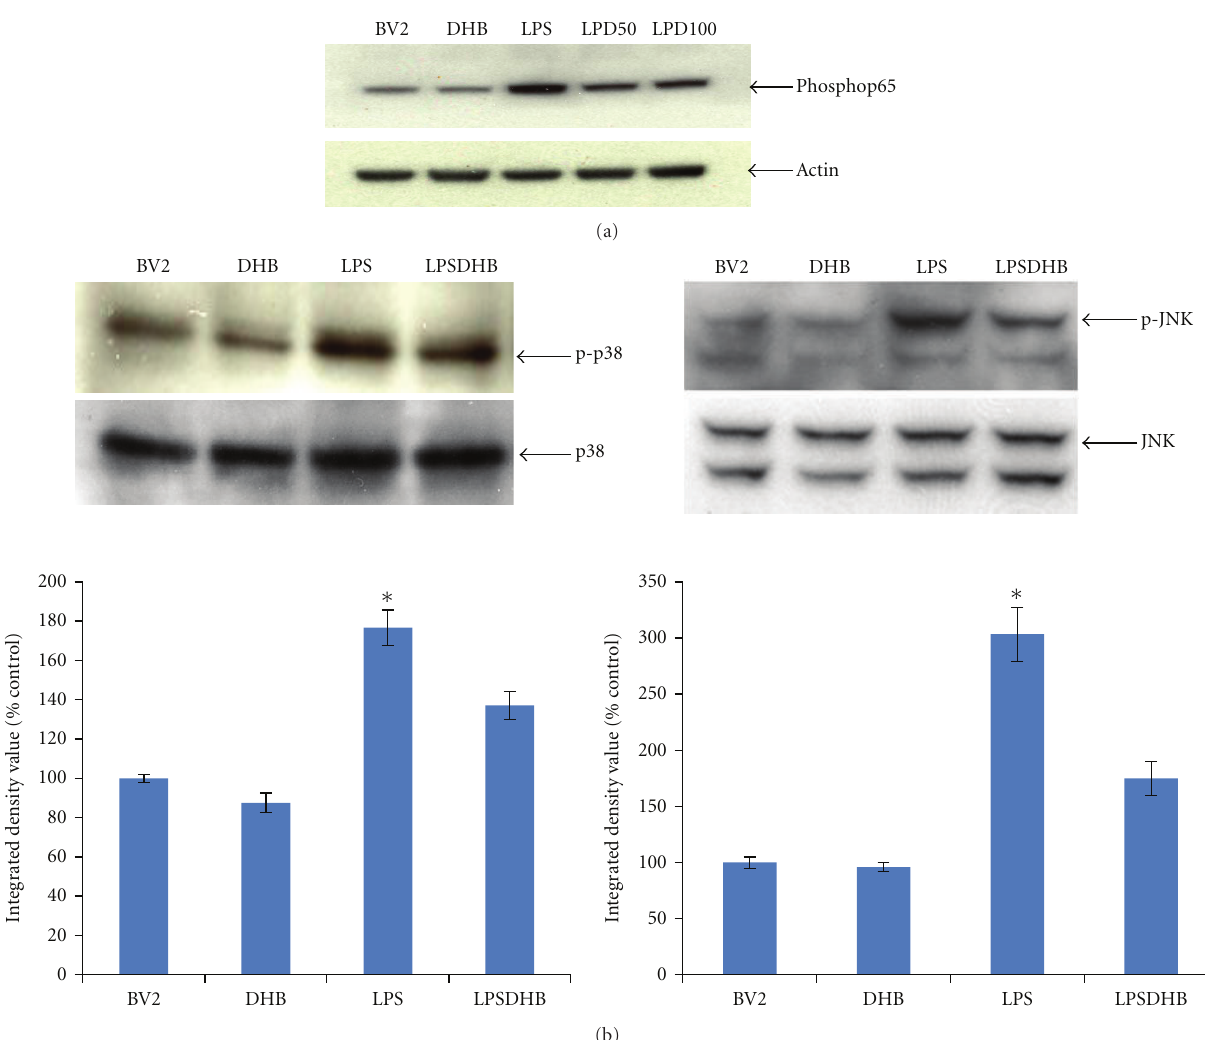
Figure 3: BV2 cells were pretreated with DHB for 1h (50 & 100 μ M) and then stimulated with LPS (100ng/mL) for a 1 h incubation period. Cells were lysed, run on a SDS-PAGE gel, transferred to PVDF membranes, and blotted with specific antibodies to (a) phosphorylated p65 NF κ B subunit or (b) phosphorylated or unphosphorylated p38 and JNK. Actin was used as a loading control. Band density (integrated density value) is expressed graphically as a percentage ratio of densitometric optical density of phosphorylated forms to that of nonphosphorylated p38 and JNK. Data (mean ± SD) are from three independent experiments; ∗ P < 0 . 05 relative to untreated control